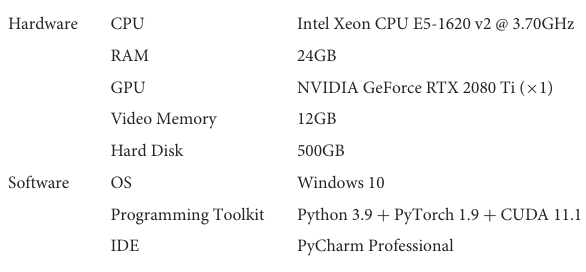
TABLE 3 The configuration of hardware and software environment for